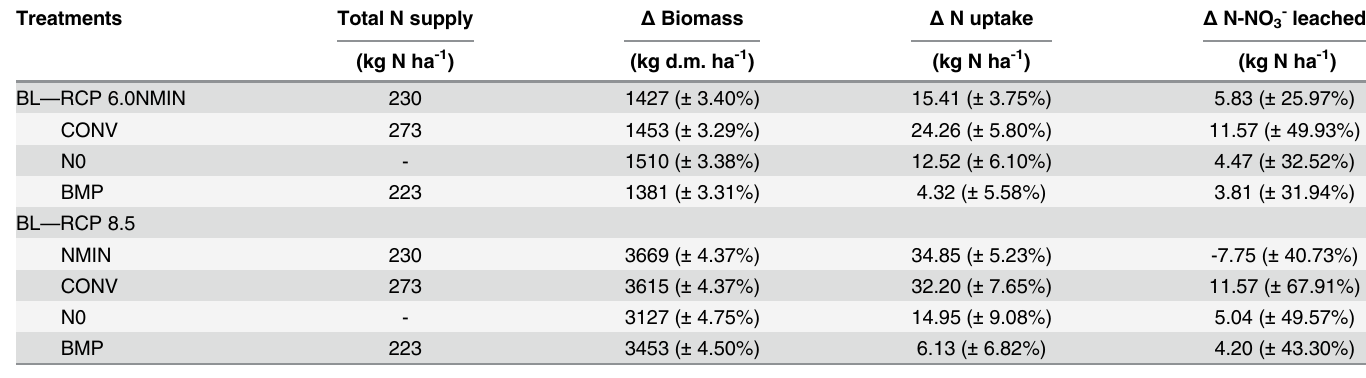
Table 9. Difference ( Δ ) in terms of model simulations between historic BL and downscaled climatic data under both RCP6.0 and RCP8.5 emission scenarios. Total biomass, N uptake, and N-NO 3- leaching are compared for each treatment in the long term rotation (2020 – 2073). Results report means and coefficients of variation. Positive value indicates that simulation obtained under RCM is superior to simulation obtained under BL